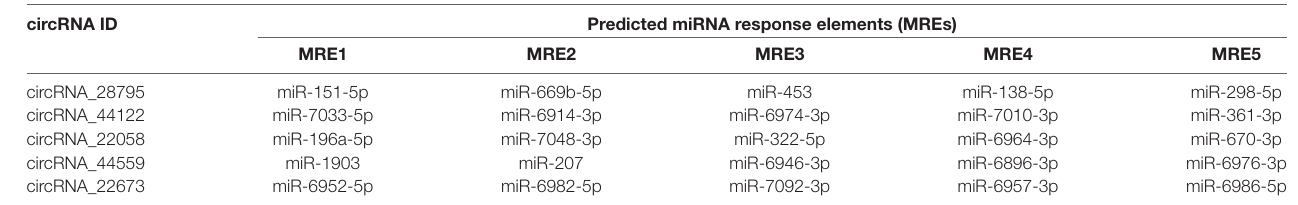
TABLE 3 | Predicted miRNA response elements of the five confirmed